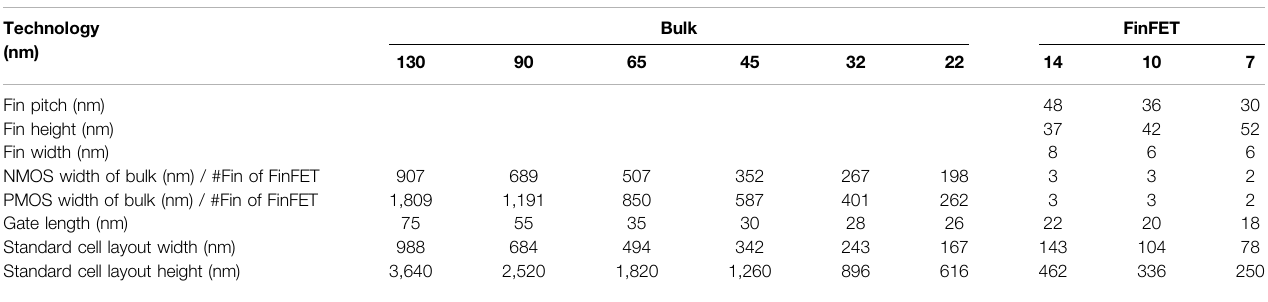
TABLE 1 | Updated transistor model of bulk (130 – 22 nm) and FinFET (14 – 7 nm) technologies. Technology